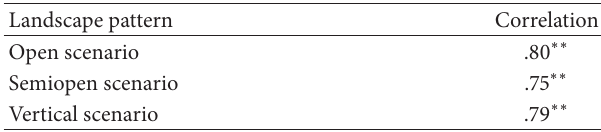
Figure 8: U-shaped relationship between LF/HF and highway length under each landscape pattern. Table 4: Correlation analysis of LF/HF and